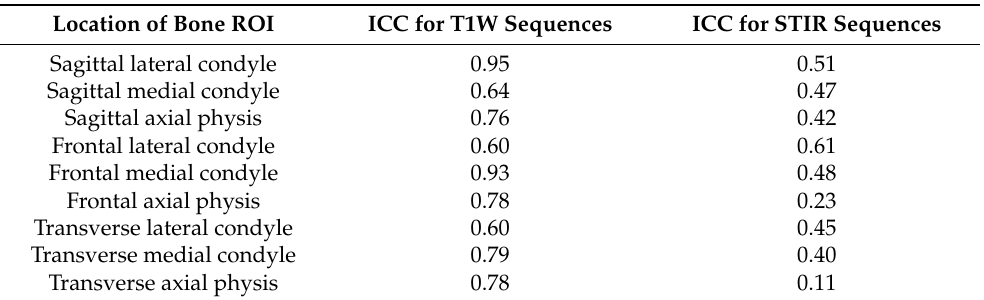
Table 2. Intraclass correlation coefficient (ICC) as intra-observer reliability measure for blinded fresh SNR data.